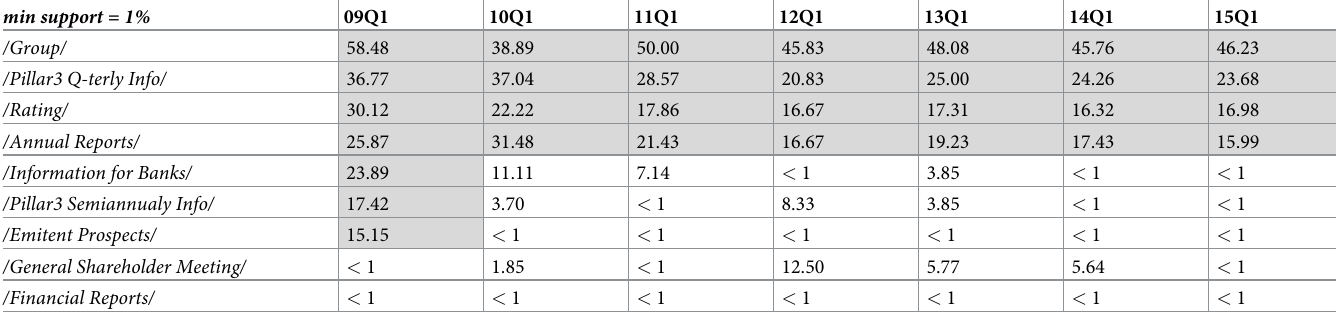
Table 2. Support: Web part traffic